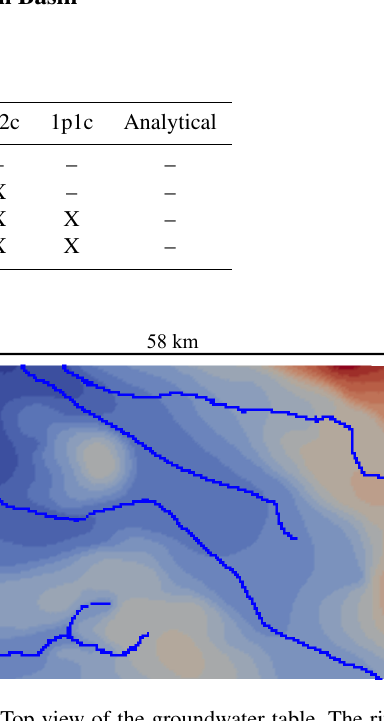
Figure 6. Top view of the groundwater table. The rivers are high- lighted in blue. The elevation values are normalized to the minimum elevation of the groundwater table (data for groundwater isolines are provided by LUGV, 2012; data for rivers are provided by LUGV,